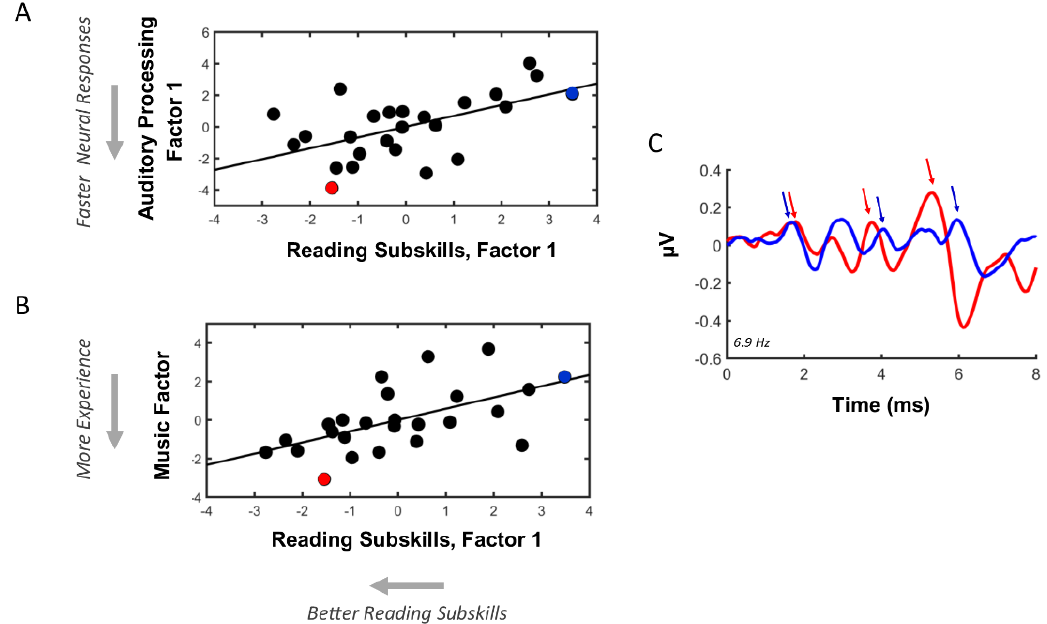
Figure 2. Summary of relations between sensorineural auditory processing, reading subskills, and musical experience. ( A ) Scatter plot between reading and auditory brainstem response (ABR) factors derived from principal component analysis (PCA). Faster neural conduction times (i.e., lower ABR factor-1 scores) are related to stronger rapid-naming skills (i.e., lower reading factor-1 scores). To aid in the visual interpretation of the relationship, arrows located on the axis denote the direction of factor loadings on each principal component. ( B ) Scatter plot between reading and musical training factors derived from PCA. More musical training (i.e., lower musical training factor scores) is associated with stronger rapid-naming skills (i.e., lower reading factor-1 scores). ( C ) Representative ABRs from a participant (red) with stronger reading subskills, faster neural conduction times, and more musical experience relative to a participant (blue) with weaker reading subskills, slower neural conduction times, and less musical experience. The participant in red had 20 years of total musical training beginning at age 2 years. The participant in blue had 3 total years of musical training beginning at age 15. Note that the latencies of the first ABR peak (e.g., ABR wave I) align across the two participants, while the later waves begin to diverge, demonstrating that the participant marked in blue exhibited slower neural conduction times. In panels A and B, the scatter dots marked in red and blue reflect these two participants. Table 9. Relations between ABR and Reading Factors. Pearson’s R computed among auditory brainstem (ABR) and reading subskills (e.g., RAN and CTOPP tests) using factors derived from PCA. Here, ABR factor 1 predominately reflected neural condition times (e.g., inter-peak latencies of the ABR waves I to III and wave I to V), while ABR factor 2 largely reflected neural response consistency. Reading factor 1 largely reflected rapid naming skills, while reading factor 2 primarily reflected phonological awareness skills. The correlations are presented with corrected probability values using the Benjamini & Hochberg (BH) correction to control the false discovery rate (FDR). Reading Subtests (Factor 1) Pearson’s R p -Value Corrected p -Value